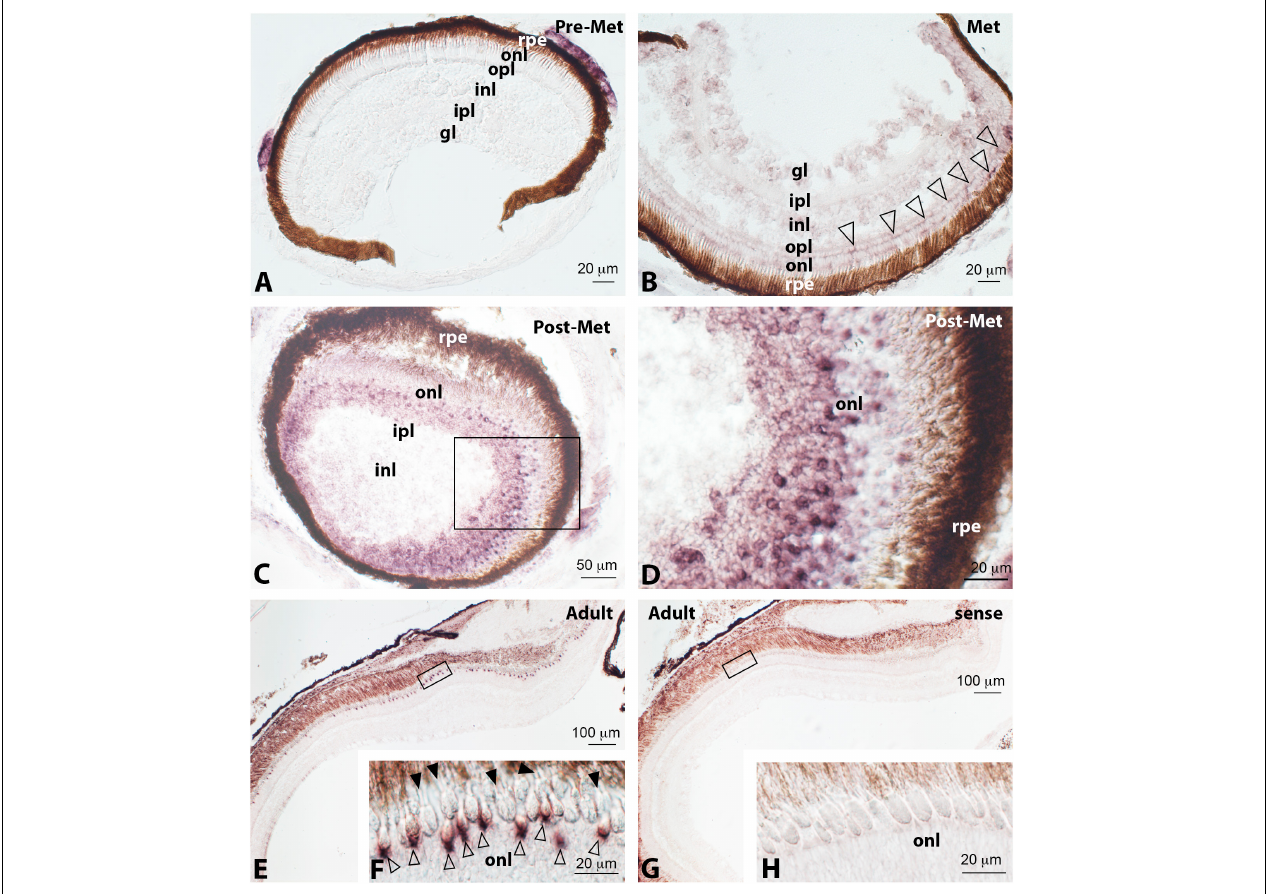
FIGURE 4 | Localisation of ultraviolet cone opsin ( sws1 ) expression in the retina of pre-metamorphic (Pre-Met; A ), metamorphic (Met; B ), post-metamorphic (Post-Met; C,D ), and adult (E–H) Senegalese sole specimens revealed by in situ hybridisation. All the photomicrographs represent antisense sections, with the exception of panels (G) and (H) , which show sense control sections. Squares in panels (C,E,G) mark the areas magnified in photomicrographs (D,F,H) , respectively. Note the absence of positive cells in pre-metamorphic specimens (A) , faint labelling of photoreceptors in metamorphic animals (white arrowheads in panel B ), and how the number of labelled photoreceptors and intensity of this labelling increase in post-metamorphic (C,D) , and adult (E,F) retina. In the adult retina, sws1 expression appears evident at the base of inner segments of single cones (white arrowheads in panel F ). In contrast, double cones were devoid of labelling ( F , black arrowheads). For abbreviations, see the legend in Figure 2 . Scale bars represent 20 µ m in panels (A,B,D,F,H) ; 50 µ m in panel (C) ; and 100 µ m in panels (E,G)